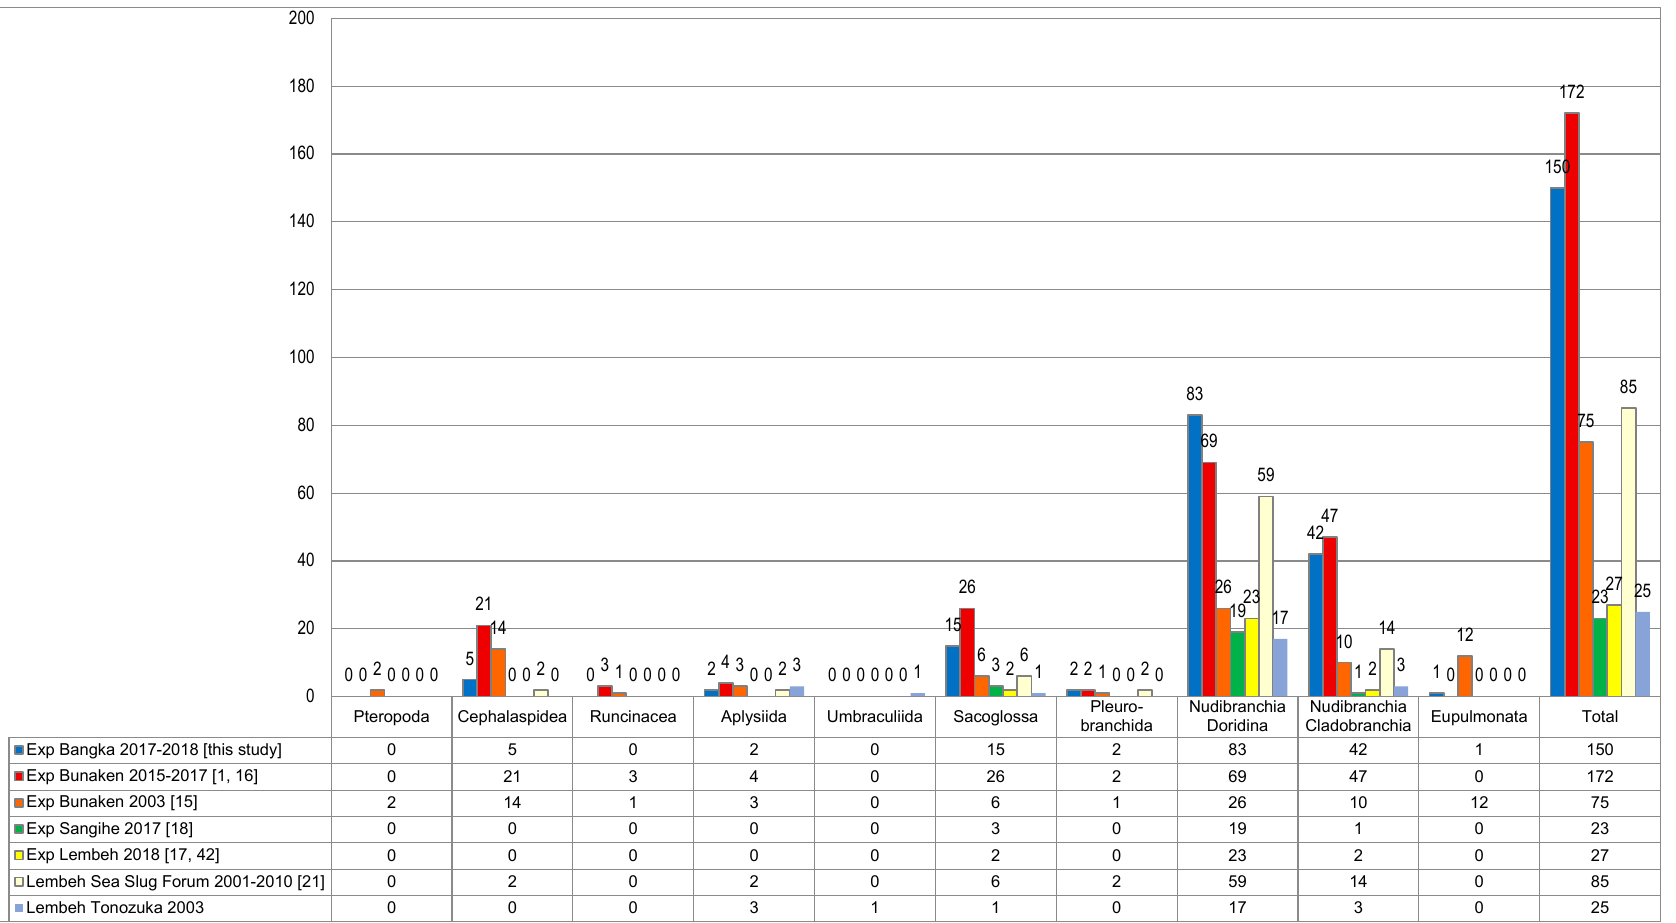
Figure 27. Higher taxa diversity of marine Heterobranchia in Bangka Archipelago compared with other areas in North Sulawesi. Considered are the expeditions to Bunaken National Park [1,15,16], to Sangihe Island [18], and to Lembeh Strait [17,39]. Additional information is accumulated for Lembeh Strait from Sea Slug Forum [21]. Numbers above columns indicate species numbers.